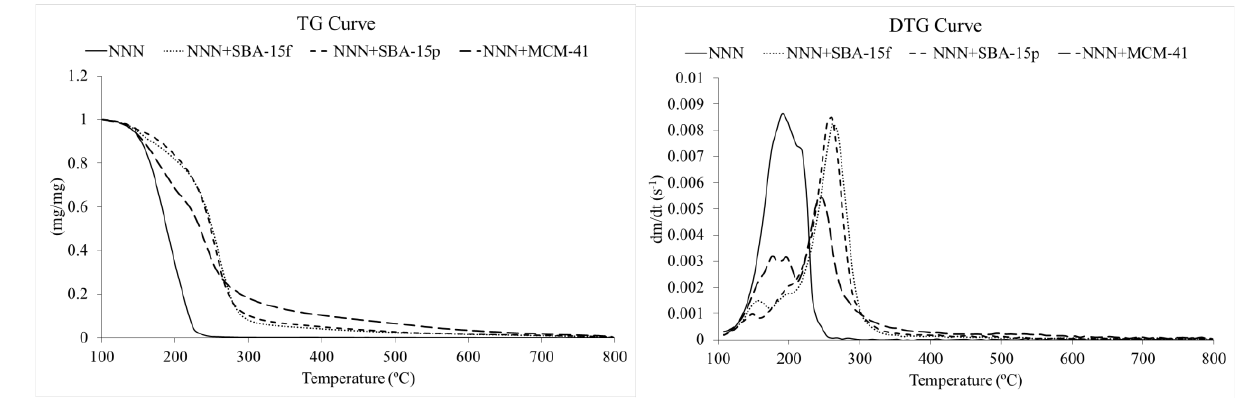
Figure 3. TG and DTG curves for experiments with NNN and NNN with three catalysts under inert atmosphere.